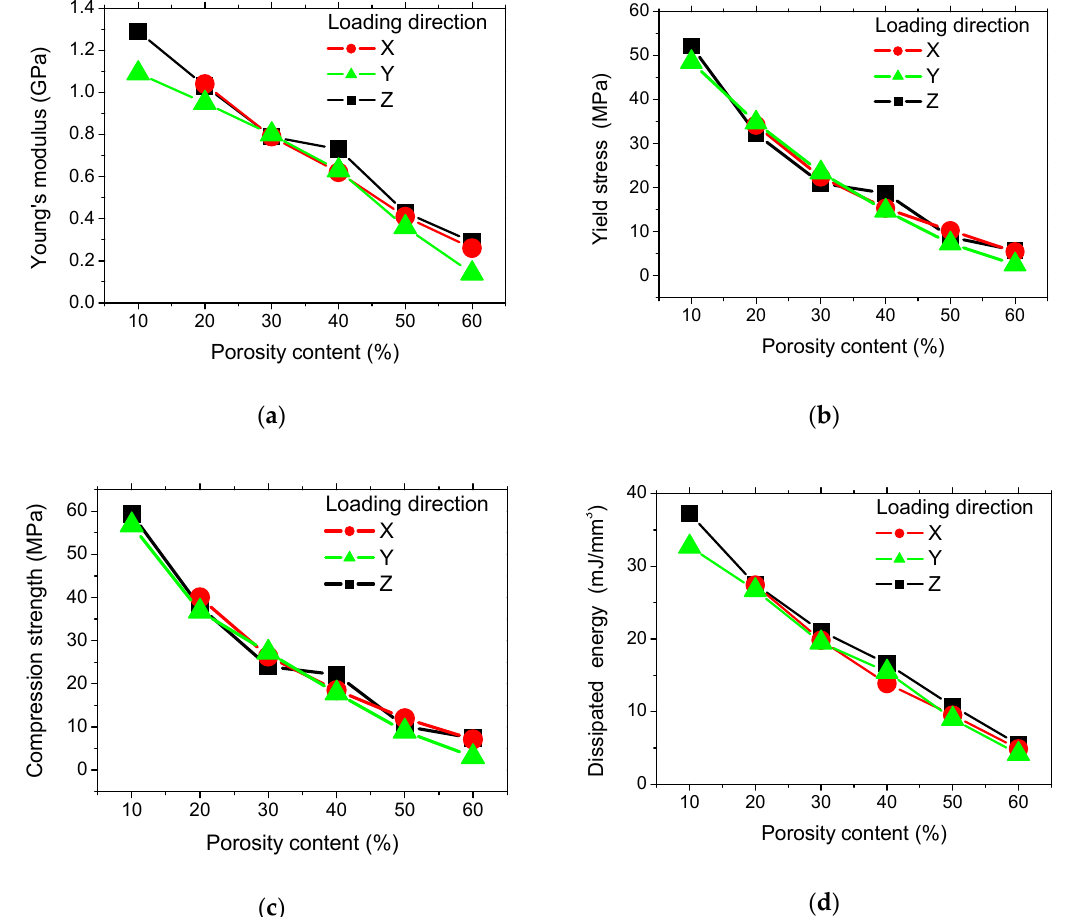
Figure 3. Evolution of mechanical properties as a function of the porosity content for 3D printed cellular PLA. ( a ) Young’s modulus, ( b ) yield stress, ( c ) compression strength, and ( d ) dissipated mechanical energy.